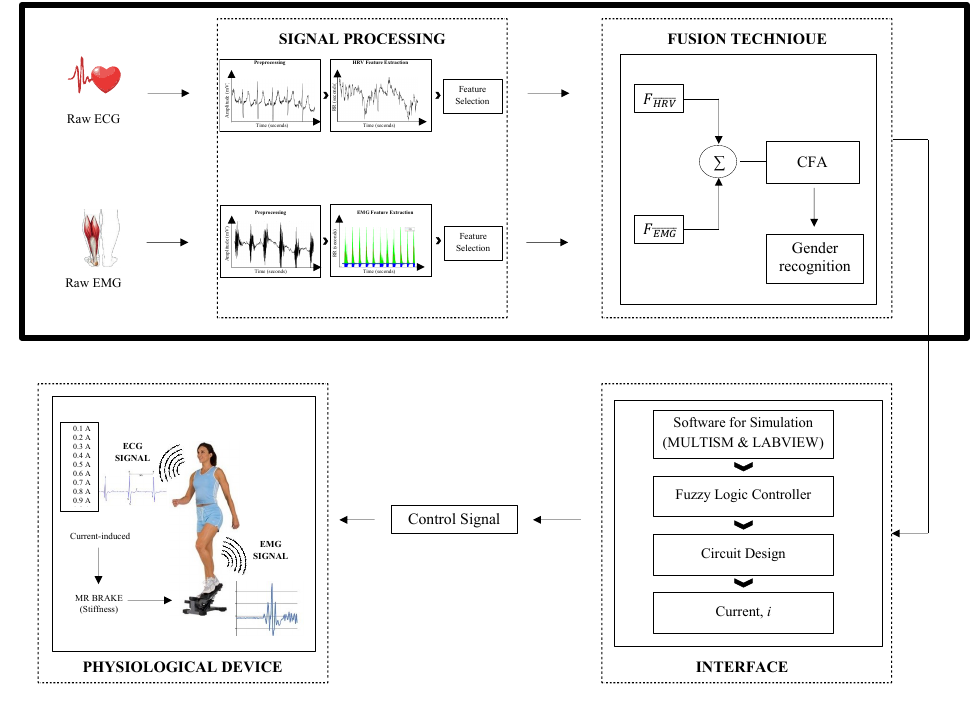
Figure 2. The need for this